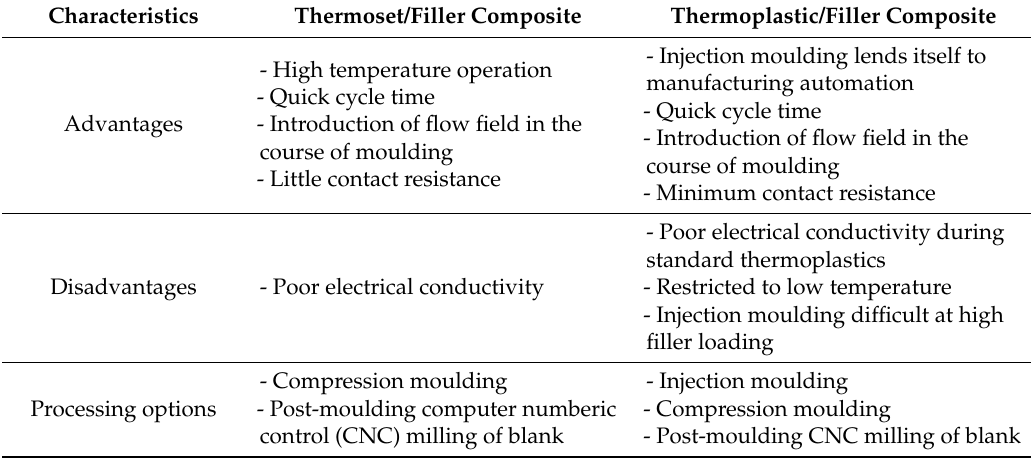
Table 3. A comparison between a thermoplastic/filler composite and a thermoset/filler composite for the bipolar plate material